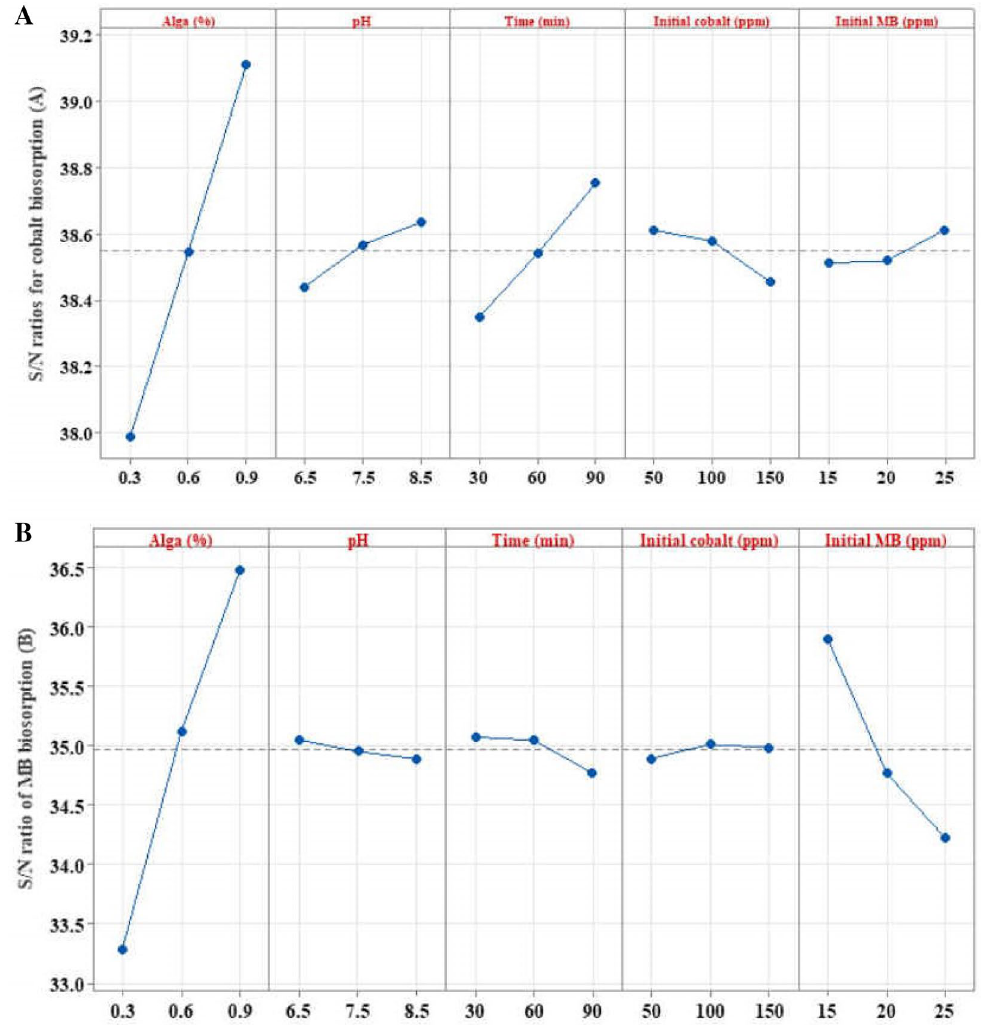
Figure 2. The main effects plot of data means of S/N ratios for cobalt biosorption ( A ) and MB biosorption ( B ) by the biomass of Sargassum latifolium , optimized based on larger is better.